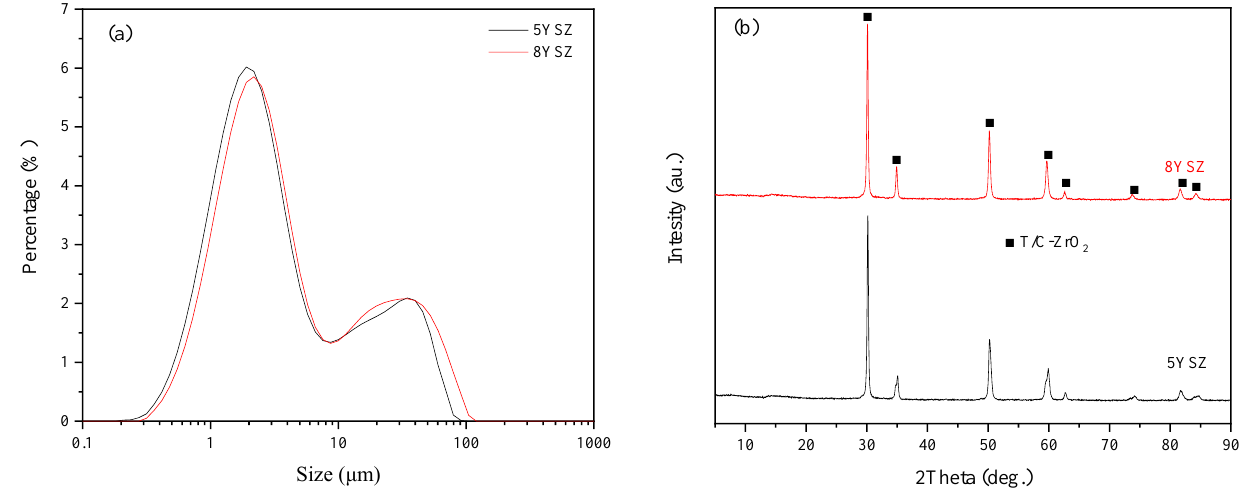
Figure 1. ( a ) Particle size distribution diagram ( b ) XRD diagram of two YSZ powders.